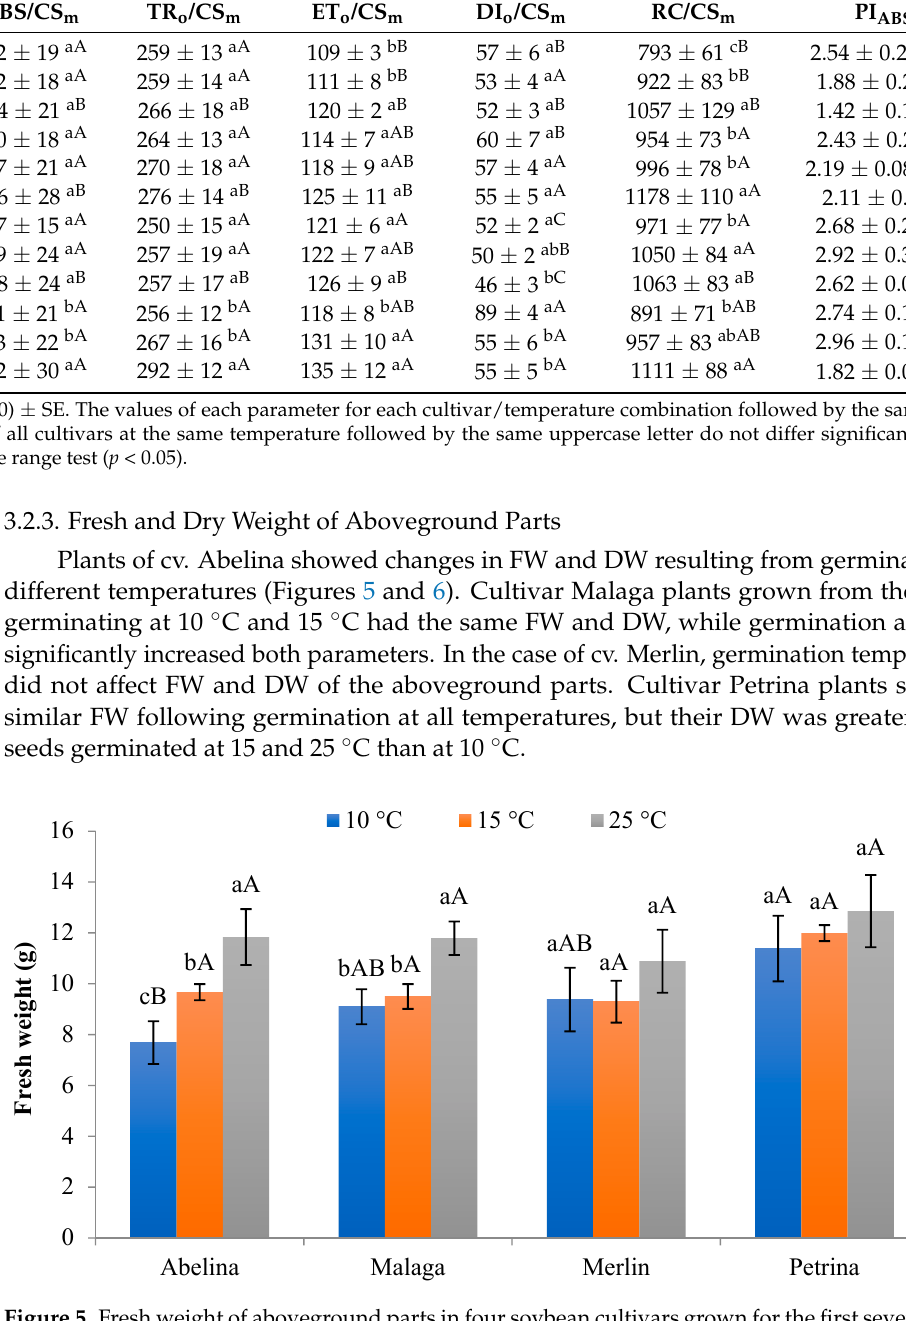
Table 4. Kinetics of chlorophyll a fluorescence in four soybean cultivars grown from seeds germinated for 48 h at different temperatures.